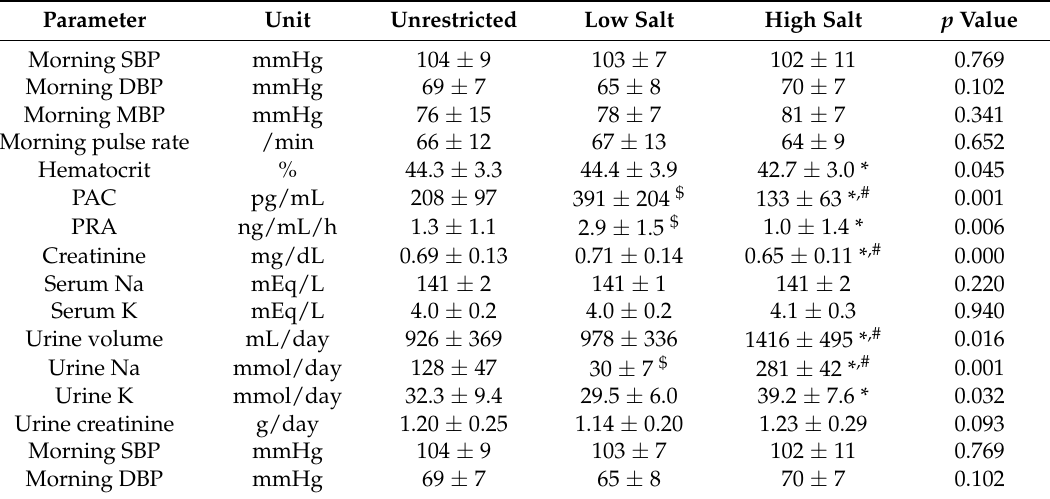
Table 2. Parameters measured at the end of each diet